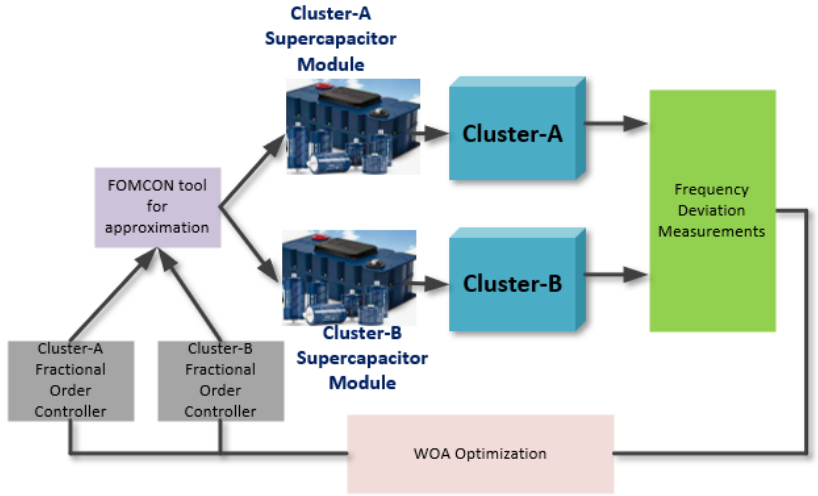
Figure 5. Supercapacitor for frequency